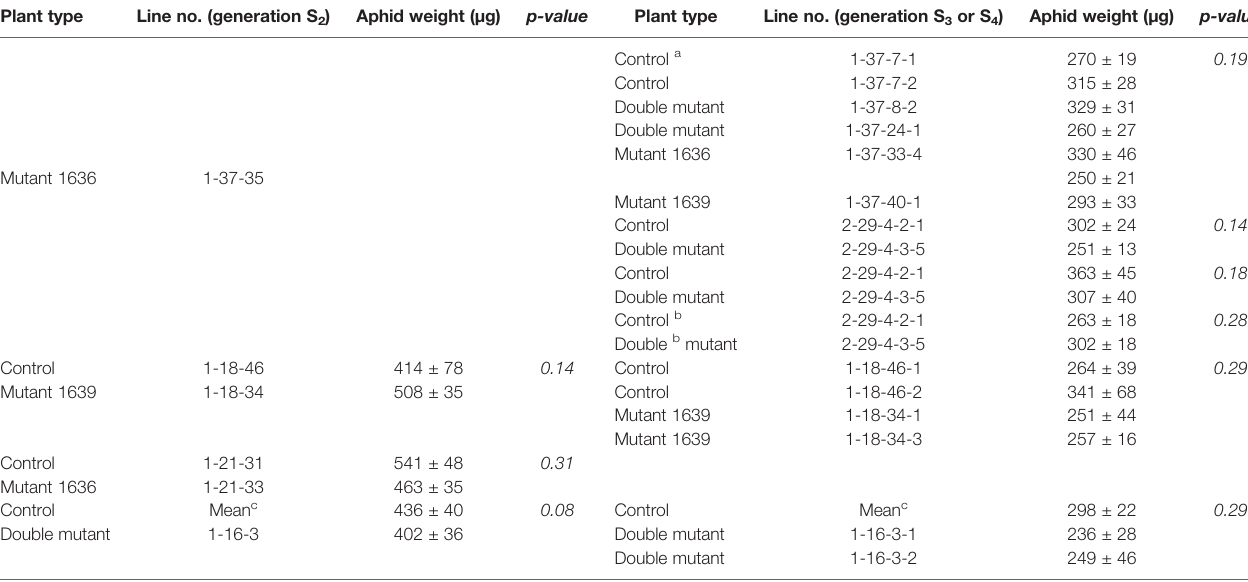
TABLE 2 | Rhopalosiphum padi individual weight (mean ± SE, n=4) after 4 d of growth on test plants. Plant type